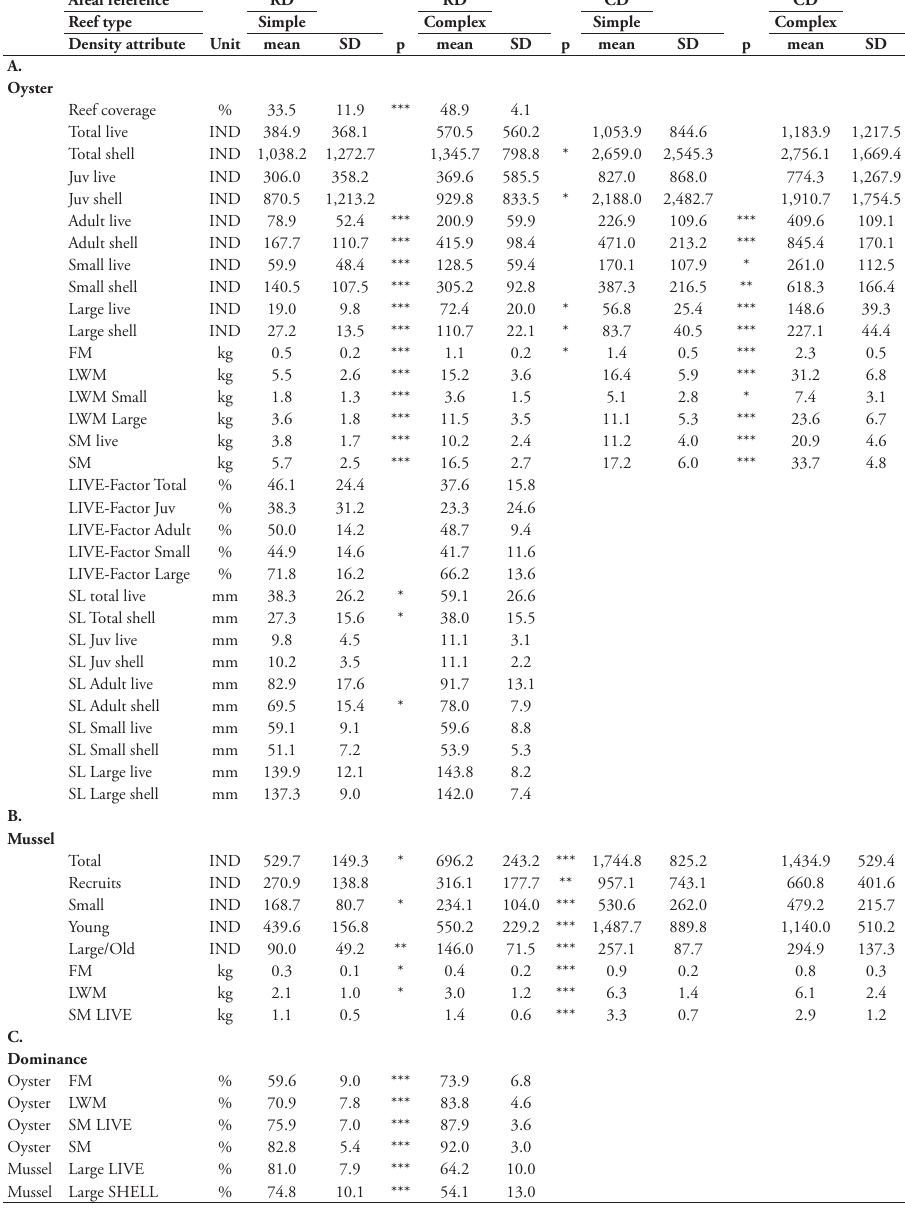
Table 3. Oyster and mussel density attributes (mean ± SD) per areal reference (RD, CD) at simple and complex reefs during the study period 2008–2013 (N = 18 reefs per reef type). IND = individuals. Addi- tionally given are proportions of live oysters (LIVE-Factor) and mean oyster SL. Dominance by biomass is given for oysters and dominance by abundance of large individuals is given for mussels. Significant differ- ence between reef types per areal reference and between RD at complex reefs vs. CD at simple reefs is